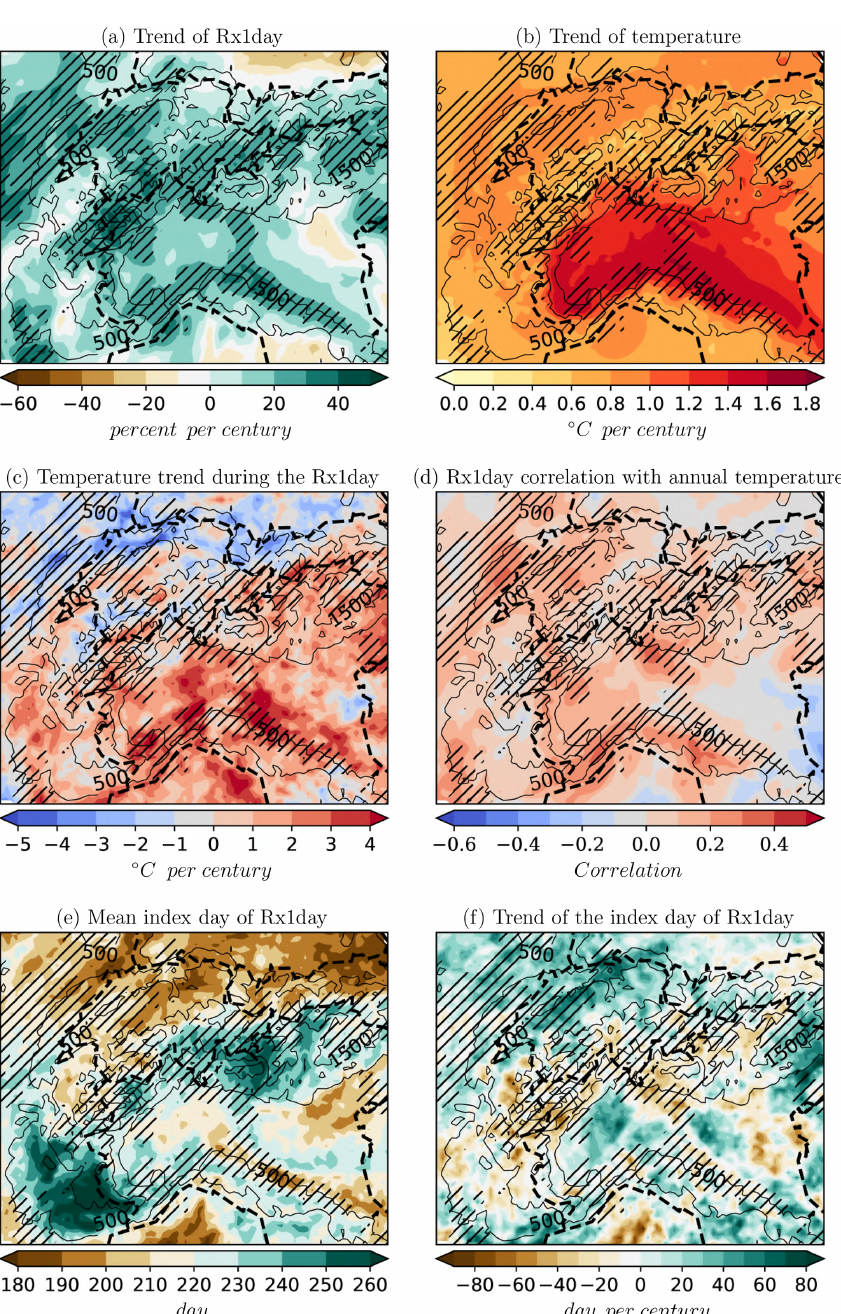
Figure 9. Rx1day intensity trend (a) , temperature trend (b) , temperature trend during the Rx1day occurrence (c) and correlation between Rx1day and annual temperature (d) . Mean (e) and trend (f) of the occurrence day of Rx1day over 1903–2010. In all the panels, the hatching highlights the areas where the Rx1day trend is positive and significant ( p value < 0.05). Temperature increase and change in the convective versus total precipitation ratio are significant ( p value < 0.05) everywhere, whereas the trend (f) of the occurrence day of Rx1day is not significant ( p value >